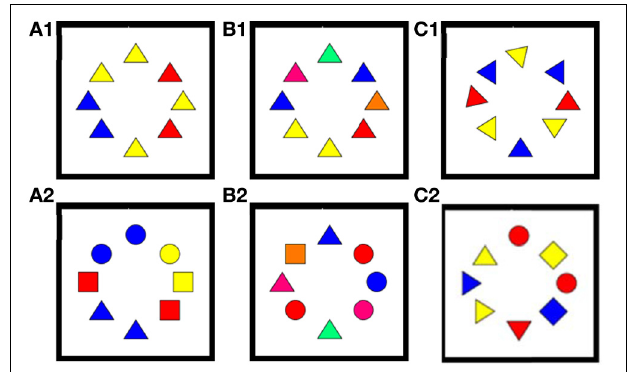
FIGURE 2 | Example stimuli for the six conditions used. The first two conditions (A,B) did not include any manipulation of orientation. (A1) A screen from the single shape, three colors condition—other trials featured eight circles or eight squares. (A2) A screen from the three shapes, three colors condition. (B1) A screen from the single shape, seven colors condition—other trials featured eight circles or eight squares. (B2) A screen from the three shapes, seven colors condition. For the two conditions A and B the rotation gene was implemented. (C1) A screen from the single shape, three colors, eight orientations condition—other trials featured eight circles or eight squares. Note that the eight alleles of the orientation gene result in only one phenotype for the circle and two phenotypes for the square due to the degree of symmetry in those shapes. Shows a screen from the three shape, three colors, eight orientations